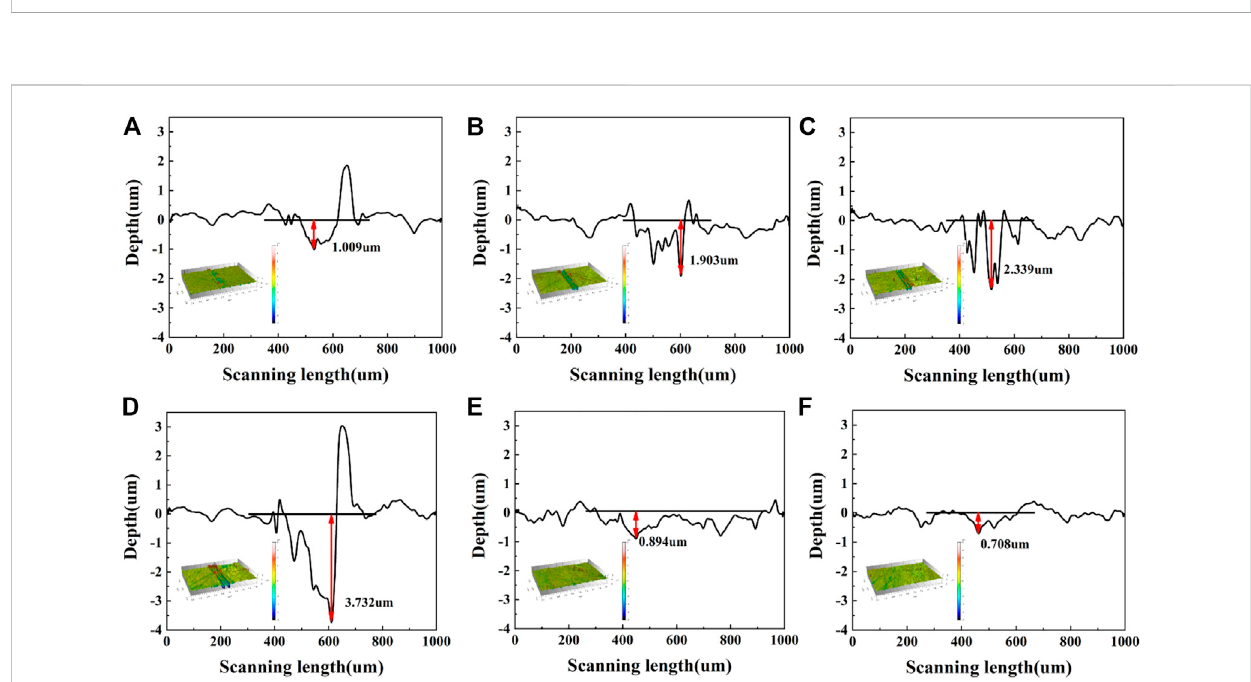
FIGURE 10 3D micrographs and the cross-section pro fi les of the wear tracks of the PI substrates treated with different graphite target currents: (A) 0.0 A (B) 1.0 A (C) 1.5 A (D) 2.0 A (E) 2.5 A (F) 3.0 A.